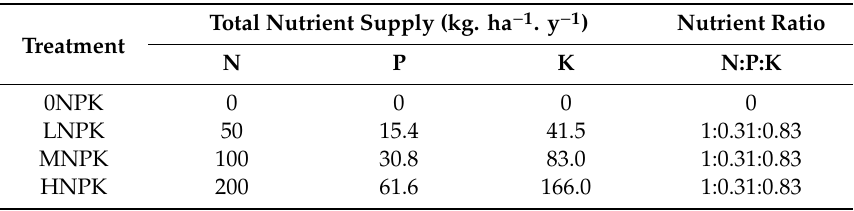
Table 1. Details of the fertilizer treatments at Vel’k á L ú ka Permanent Grassland Experiment (PGE).